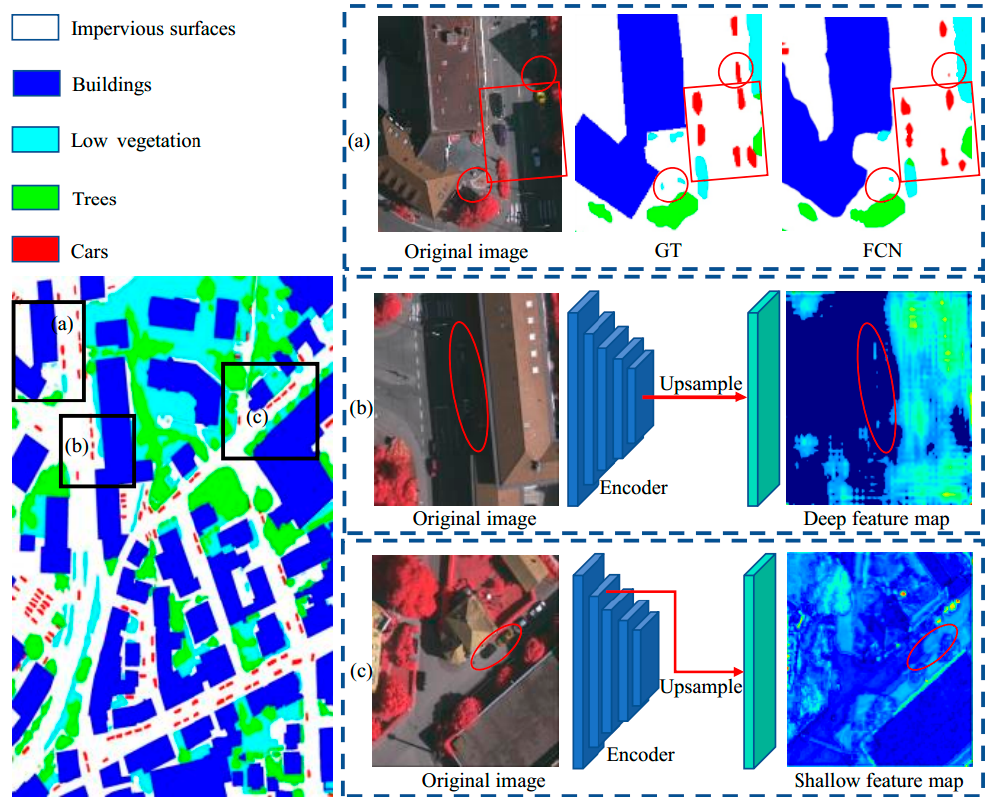
Figure 1. Some examples of multi-scale semantic segmentation and feature maps of remote sensing images. ( a ) The comparison between the ground truth and the segmentation effect of multi-scale objects in Fully Convolutional Network (FCN) is shown. ( b ) displays the visualization of deep feature map, in which the marked area is noise. ( c ) displays the visualization of shallow images.